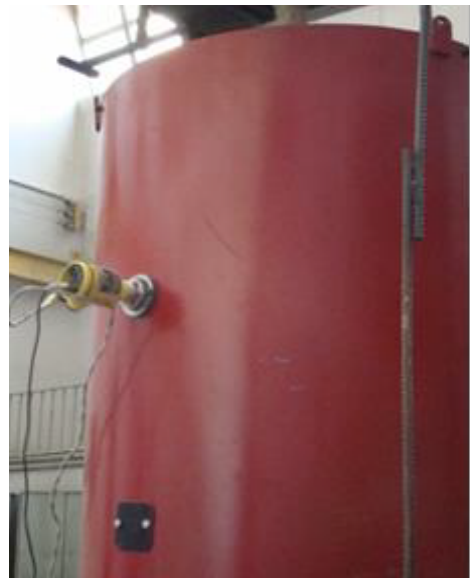
Fig.5 The used pressure transducer Figure 5: The used pressure